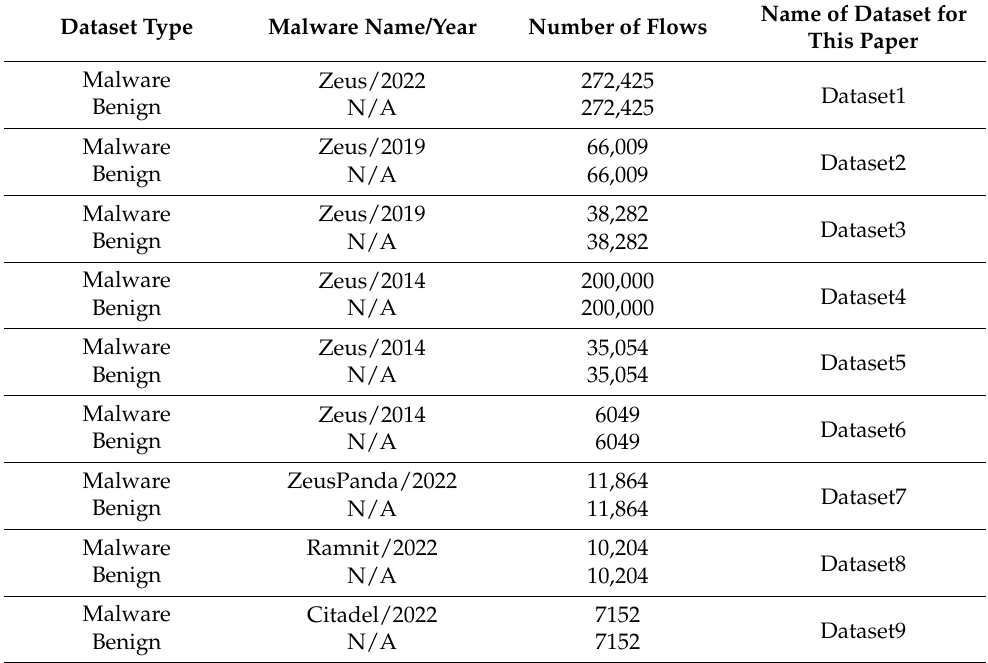
Table 2. Datasets used in this